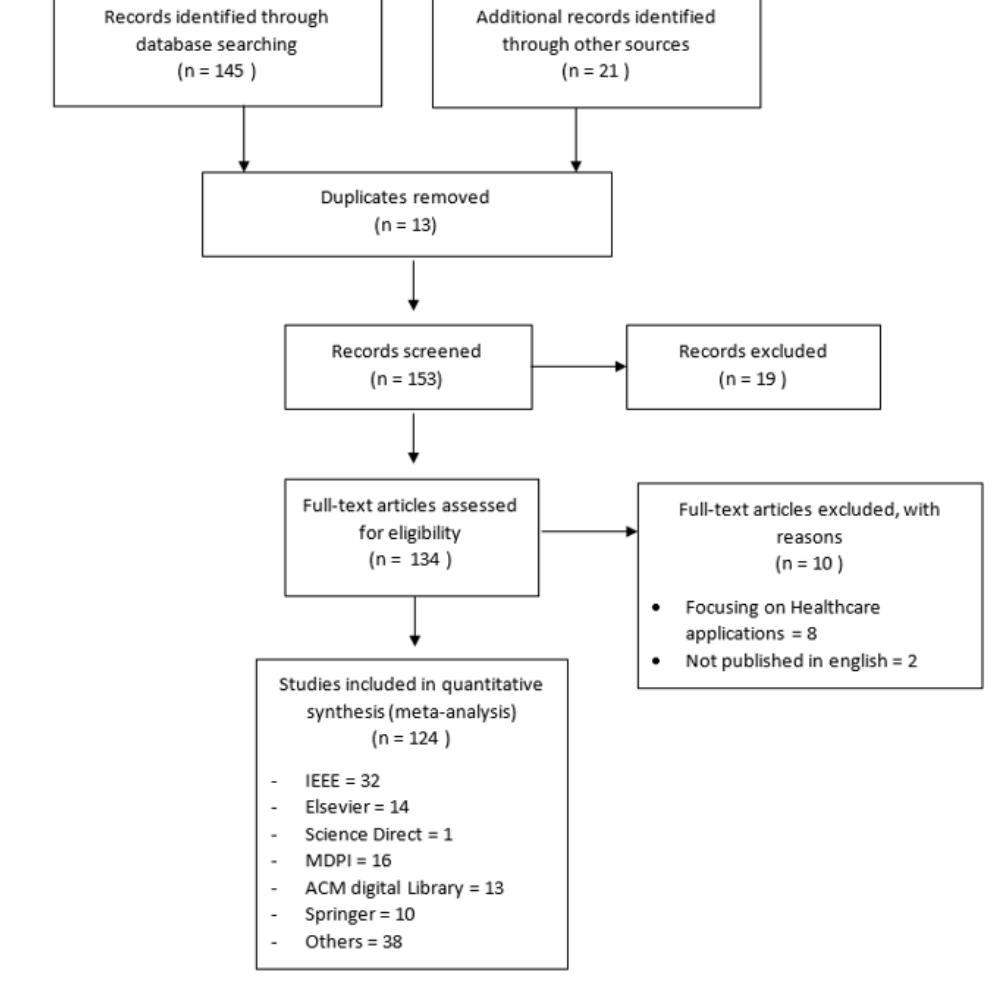
Figure 3. The study selection